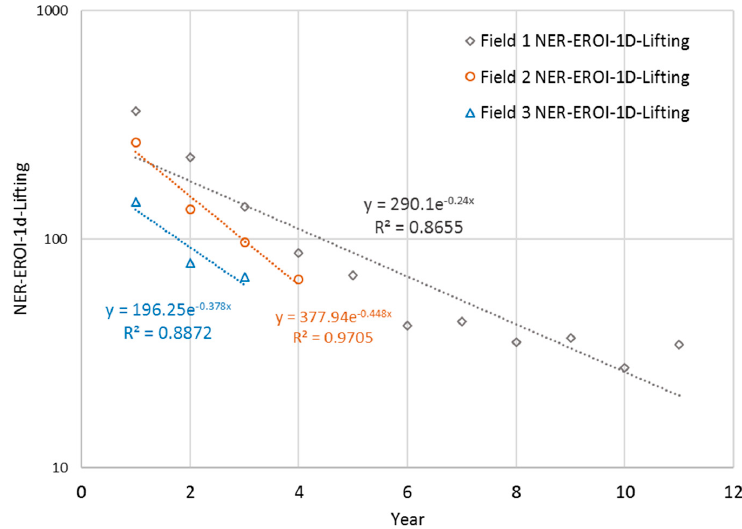
Figure 5. NER-EROI-1d Lifting regression analysis (linear).